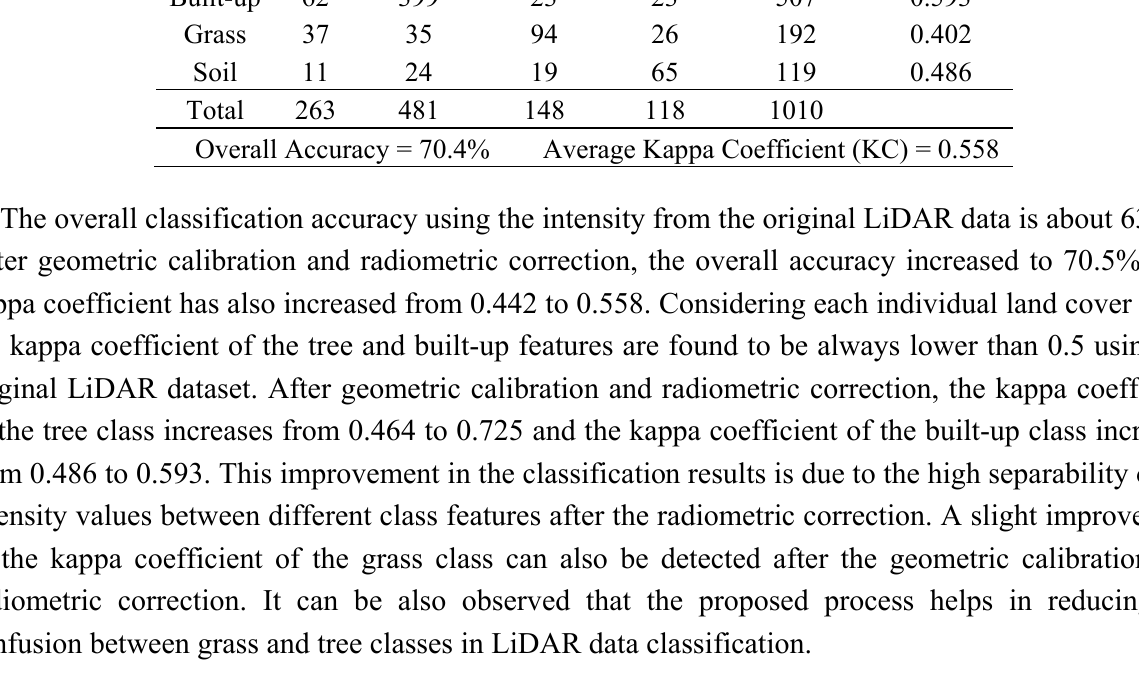
Figure 6. Comparison of classification results of original and the geometrically calibrated and radiometerically corrected LiDAR